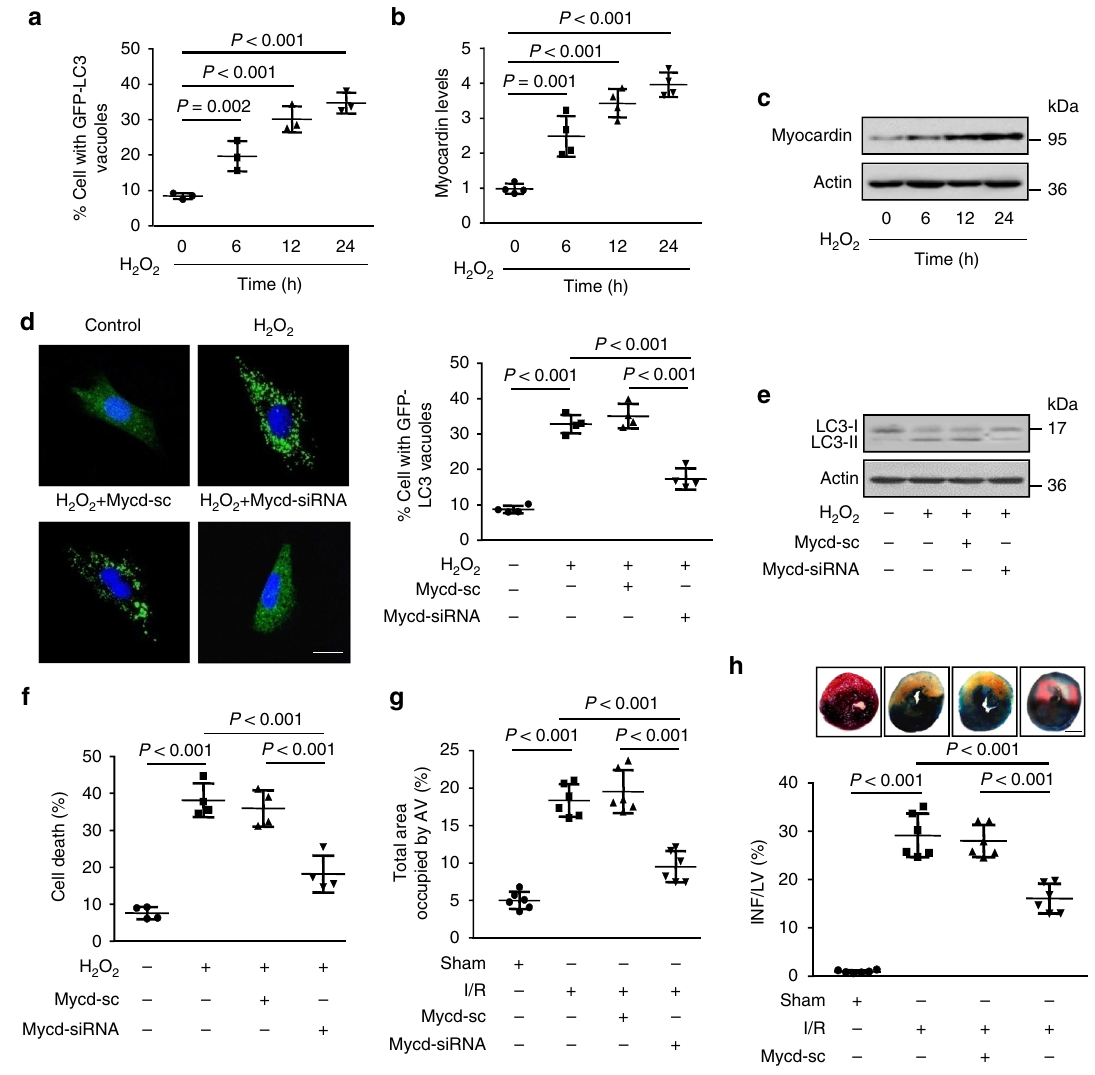
Fig. 1 Myocardin participates in the regulation of autophagy. a H 2 O 2 induces autophagosome formation. Cardiomyocytes were infected with GFP-LC3 and then treated with H 2 O 2 at the indicated time. The extent of autophagy was assessed by analyzing staining patterns of GFP-LC3, and quantitation of autophagy was shown. n = 3. b , c H 2 O 2 induces an increase in myocardin levels. Cardiomyocytes were treated with H 2 O 2 at indicated time. Myocardin mRNA levels ( b ) and protein levels ( c ) were analyzed. n = 4. d Knockdown of myocardin inhibits punctate accumulations of GFP-LC3 induced by H 2 O 2 . Cardiomyocytes were infected with adenoviral myocardin siRNA (Mycd-siRNA) or its scramble form (Mycd-sc), then infected with GFP-LC3. Twenty-four hours after infection cells were treated with H 2 O 2 . Representative photos of GFP-LC3 cells were shown in the left panel (Bar = 20 μ m) and the percentage of cells with GFP-LC3 puncta was quanti fi ed in the right panel. n = 4. e Representative immunoblot for conversion of LC3-I to LC3-II. Cardiomyocytes were infected with adenoviral Mycd-siRNA or Mycd-sc. Twenty-four hours after infection cells were treated with H 2 O 2 . The positions of LC3-I and LC3-II are indicated. n = 3. f Knockdown of myocardin reduces cell death. Cells were treated as described in ( e ). Quantitation of cell death was shown. n = 4. g Myocardin knockdown suppresses autophagy in vivo. Mice were injected with Mycd-siRNA or Mycd-sc as described in methods section, and then were subjected to 45 min ischemia and 3 h reperfusion (I/R). Quanti fi cation of autophagic vacuoles in the area-at risk was shown. n = 6. h Knockdown of myocardin reduces myocardial infarction upon I/R in vivo. Mice were treated as described in ( g ). The upper panels are representative photos of midventricular myocardial slices (Bar = 2 mm). The low panel shows infarct sizes. LV left ventricle, INF infarct area. n = 6